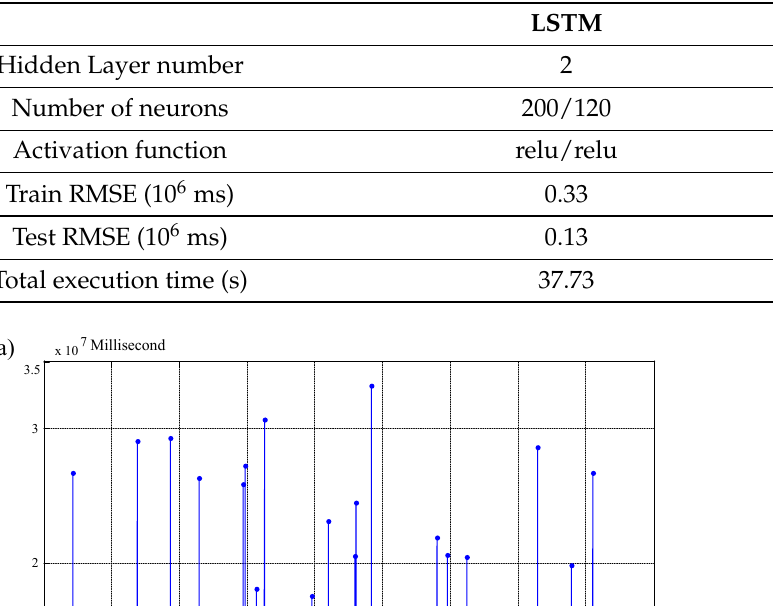
Table 2. Event prediction of water consumption in ms with the LSTM and BPNN.